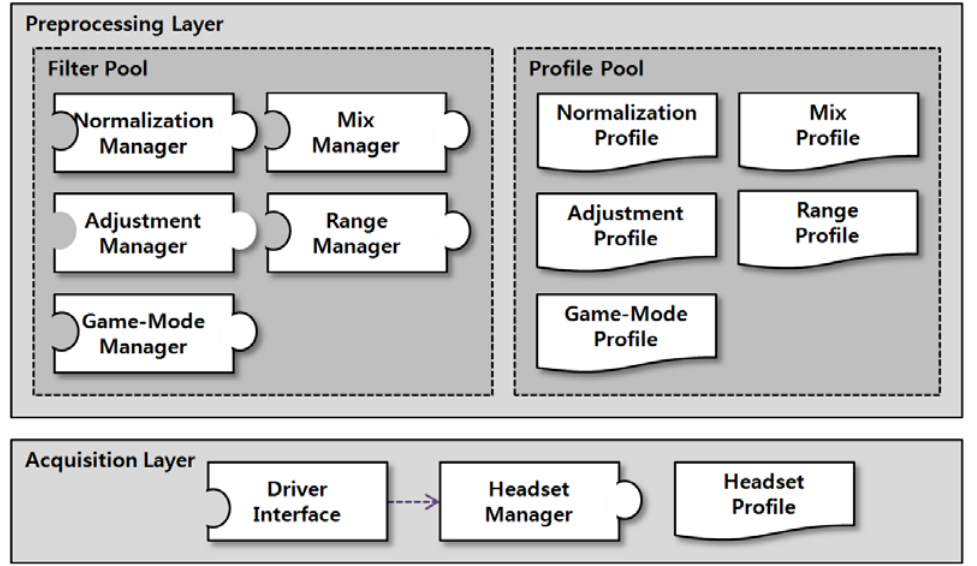
Figure 5. Structure of the BCI framework. acquisition layer unites BCI driver interfaces and preprocessing layer controls